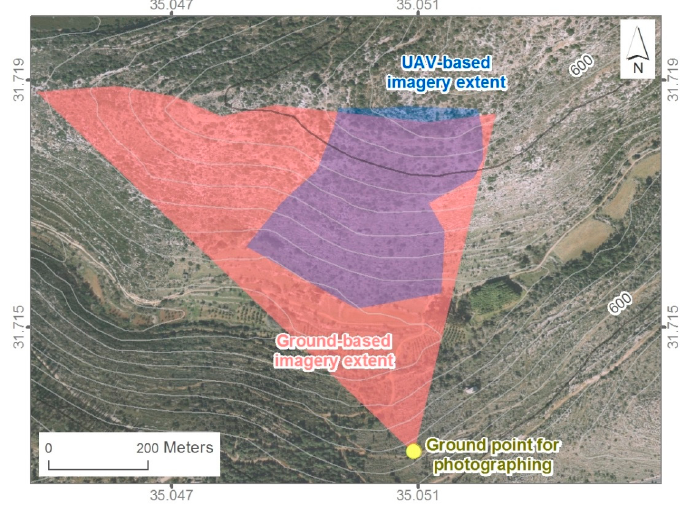
Figure 3. Map of Unmanned aerial vehicle image coverage in the Mata (M) site. The grey lines represent elevation contours at vertical intervals of ten meters.